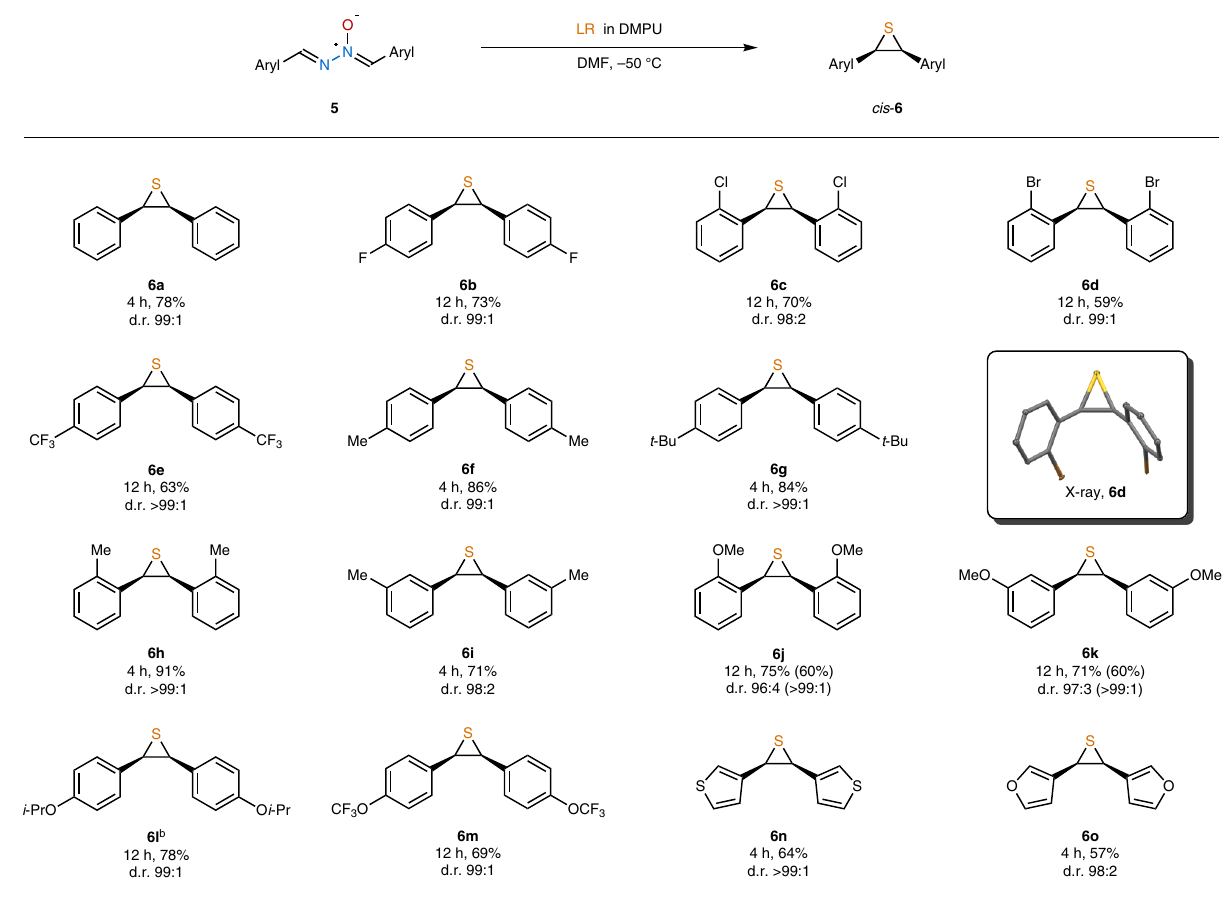
Fig. 3 | Substrate scope of LR-mediated cis- diarylthiirane synthesis. a Reaction conditions: 5 (1.0mmol) in DMF (5.0mL) and LR (1.0mmol) in DMPU (5.0mL). Isolated yields after column chromatography are given. Diastereomeric ratio was